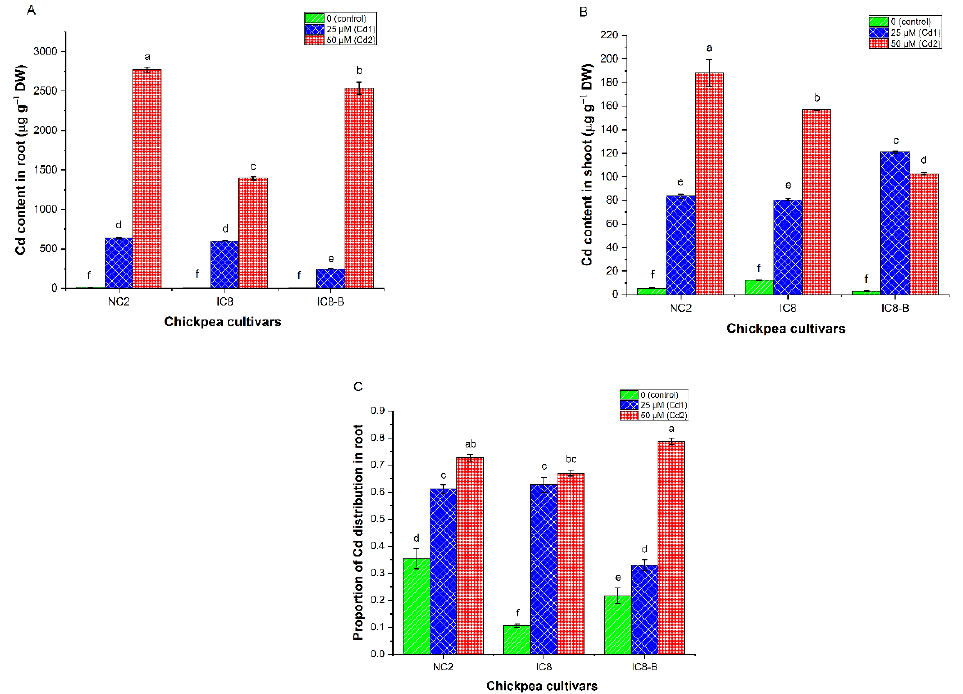
Table 5. Dry weight tolerance indices for root (TI r ), shoot (TI s ) and total plant (TI tp ) of chickpea seedlings grown in a nutrient medium under Cd stress at the rate of 25 µM (Cd1) and 50 µM (Cd2) with mean values ± SE, ( n = 3).